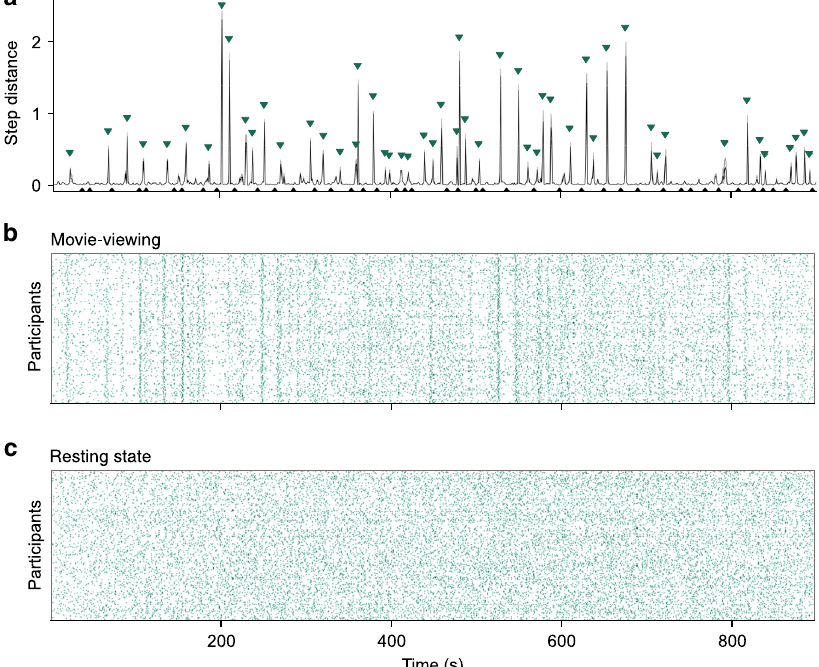
Fig. 2 Identifying transition and meta-stable timepoints during movie-viewing and rest. a A participant ’ s mean step distance vector during one mv-fMRI run, with 95% percentile bootstrap con fi dence interval ribbon (largely imperceptible ribbon indicates stability over t -SNE iterations). Transition timepoints (green triangles) and meta-stable timepoints (black triangles) identi fi ed by a peak- fi nding algorithm. b All participants ’ transition timepoints for the same mv-fMRI run, with many peaks overlapping those of the example participant in a . c All participants ’ transitions for one rs-fMRI run. Alignment of peaks in a but not c reveals stimulus control over